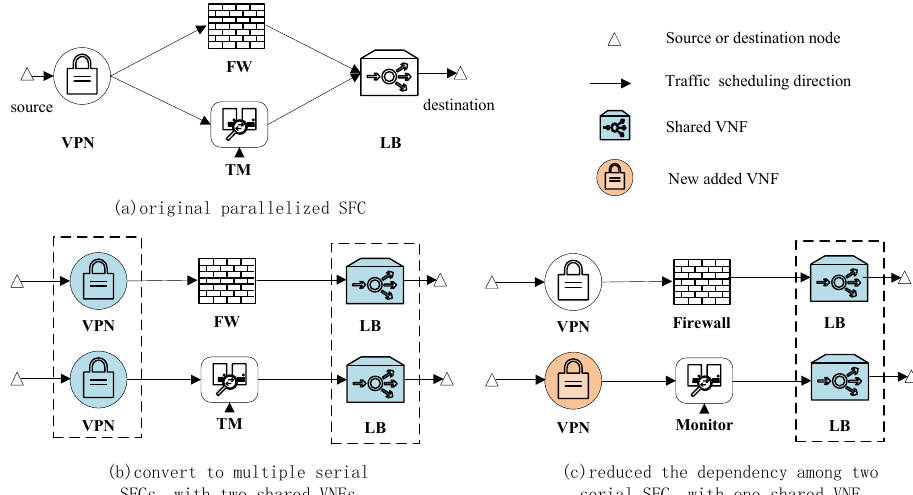
Figure 5. Case study of real-world parallelized